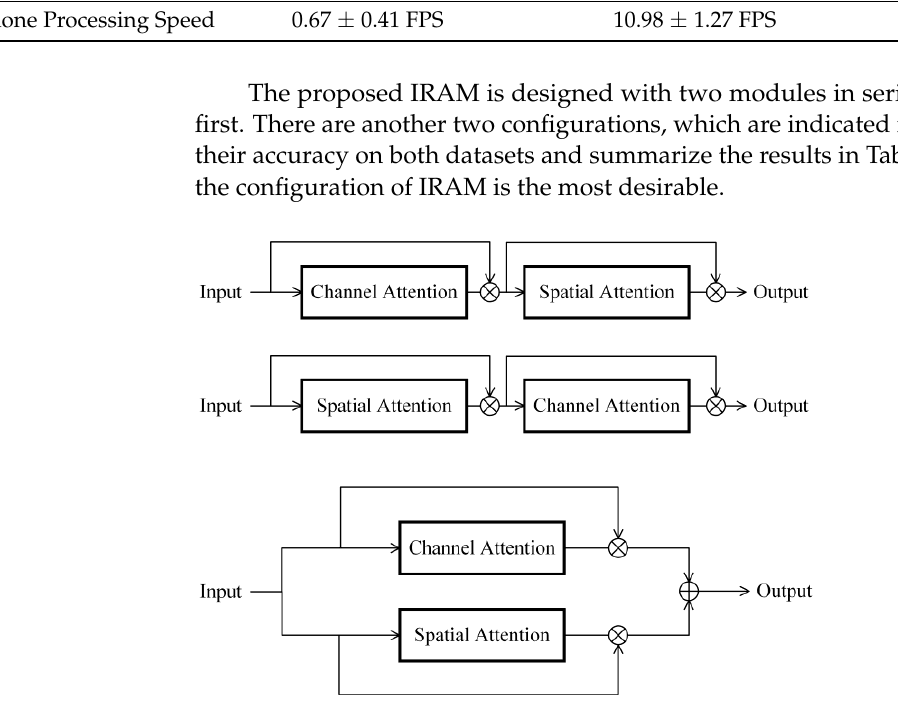
Table 6. Attention module configure evaluation.